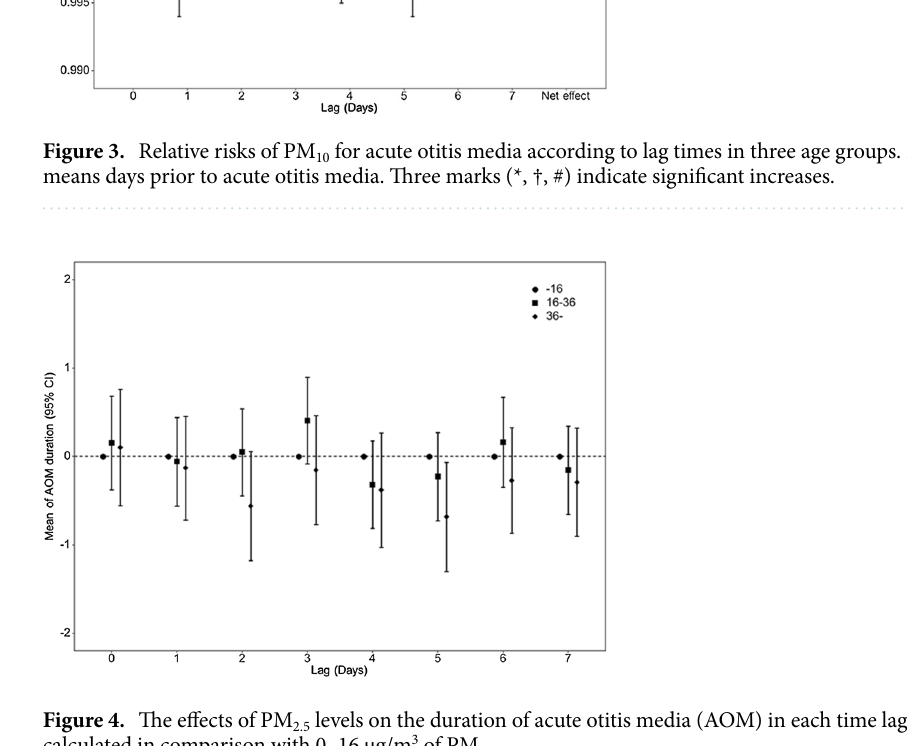
Figure 4. The effects of PM 2.5 levels on the duration of acute otitis media (AOM) in each time lag. *The value is calculated in comparison with 0–16 μg/m 3 of PM 2.5